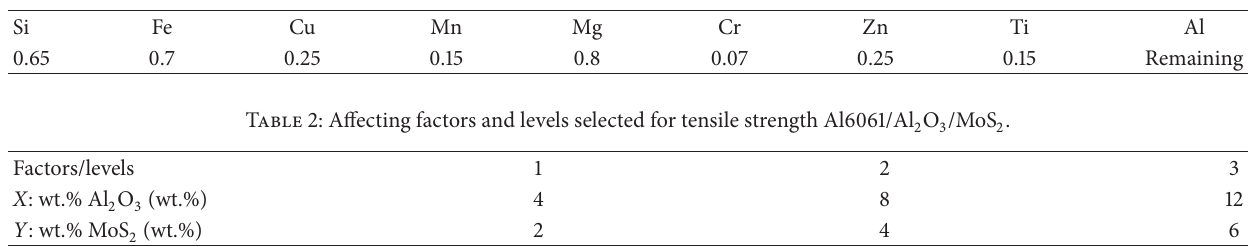
Table 1: Chemical composition of Al6061 alloy.